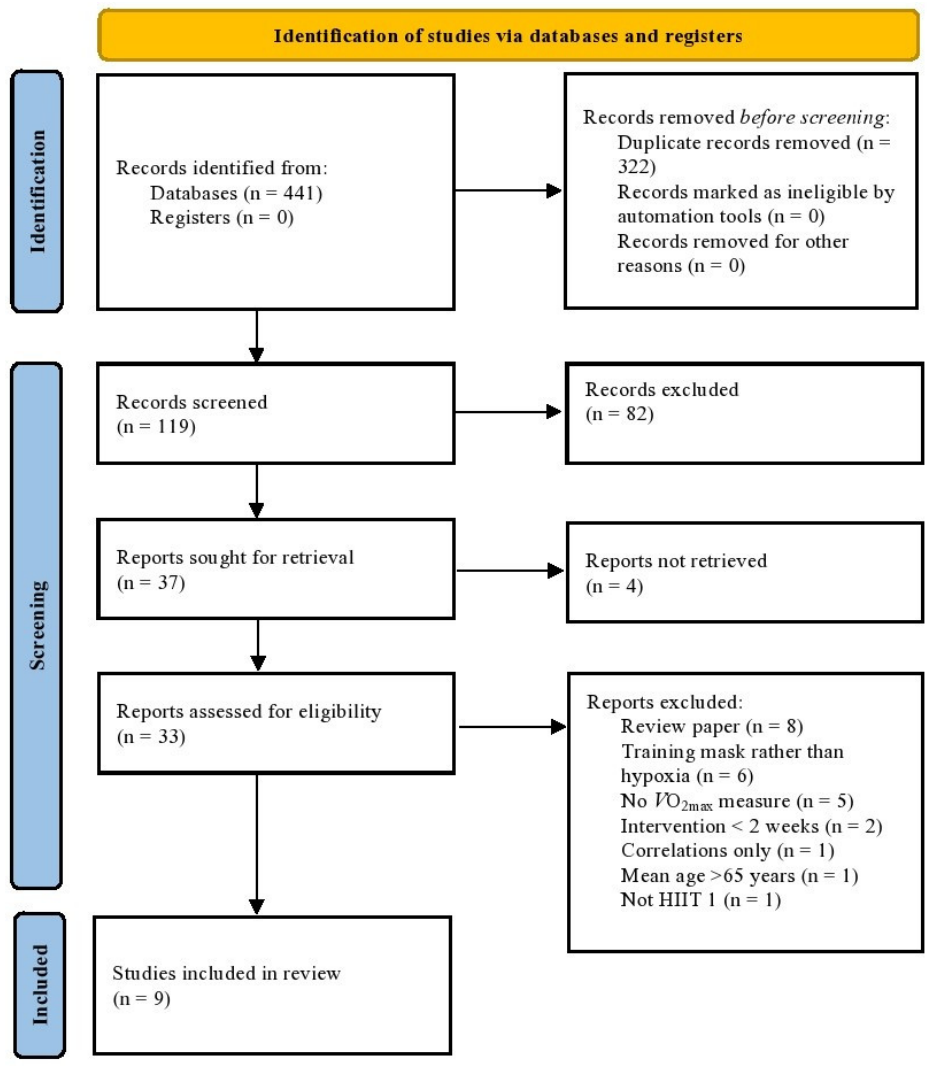
Figure 1. Preferred Reporting Items for Systematic Reviews and Meta-Analyses (PRISMA) flow diagram detailing inclusion and exclusion of potential studies as well as final number of studies included in the systematic review and meta-analysis. RCT = randomised control trial; CT = control trial.